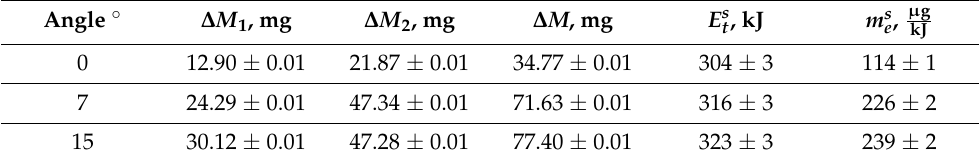
Table 1. The decrease in the electrodes’ mass, the energy release in the interelectrode gap, and the energy efficiency of synthesis with the